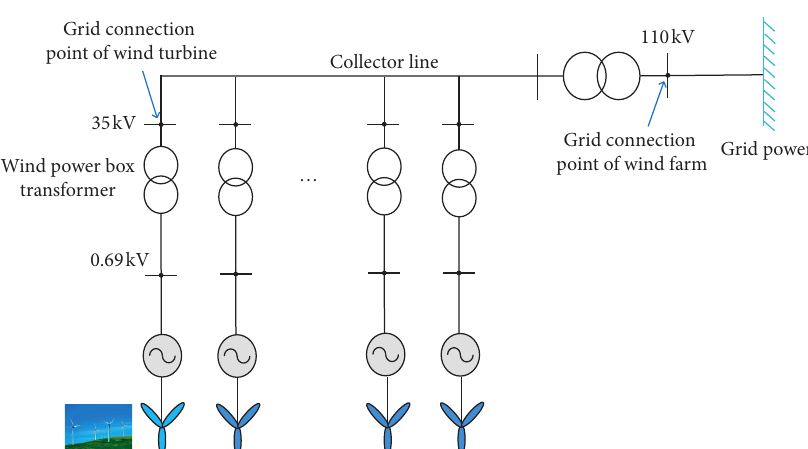
Figure 5: Structure diagram of the FSCWT grid-connected system.